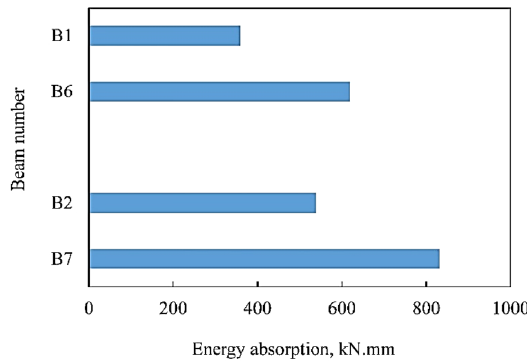
Fig. 14 Energy absorption for beams B1, B2, B6 and B7